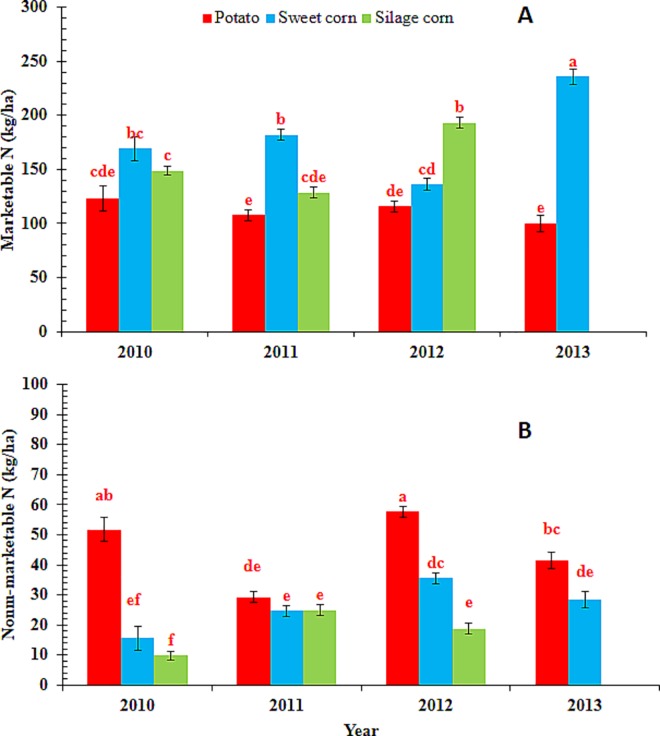
Comparison of A) nitrogen exported off the farm in sold products (marketable N) and B) crop residue N left in the field between three crops (potato, sweet corn and silage corn) and four growing seasons (2010to 2013) at the study farm in the Middle Suwannee River Basin, Florida. Silage corn was studied only between 2010 and 2012. Mean values of marketable N and crop residue N (represented by individual bars and their standard errors for three crops) followed by different letters indicate significant difference at α = 0.05 level.